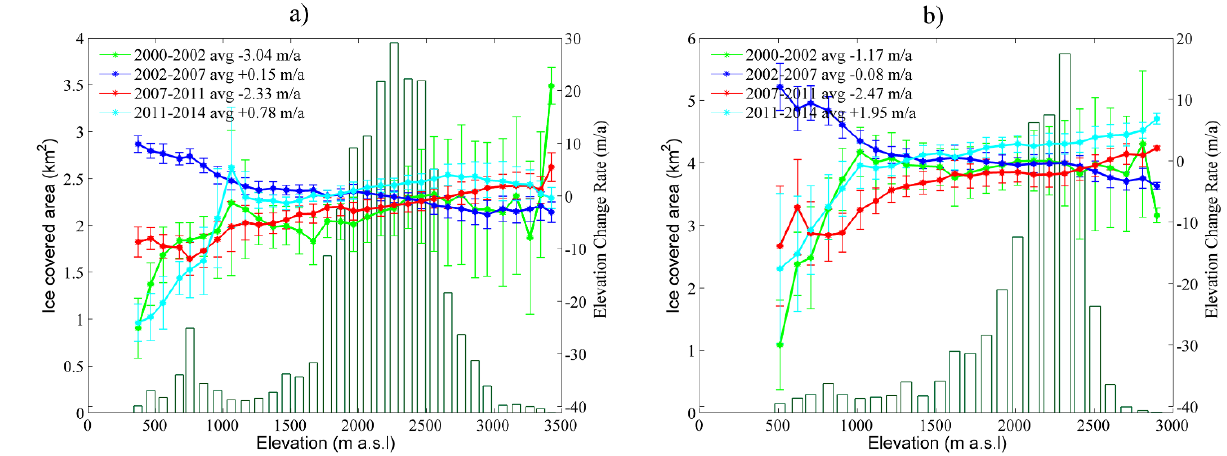
Figure 11. Hypsometry and rate of glacier elevation change versus elevation on ( a ) Fox Glacier ( b ) Franz Josef Glacier. The colored lines represent the dh/dt estimated for each 100 m elevation bin, plotted with their corresponding standard deviations as error